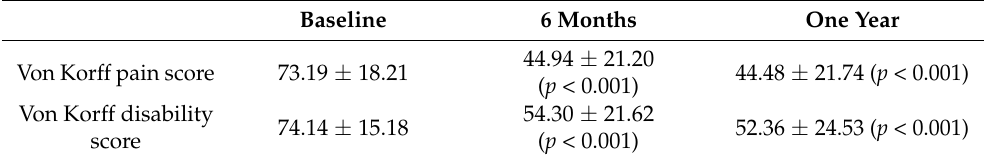
Table 2. Von Korff scores at baseline, at 6 months and after 1 year.